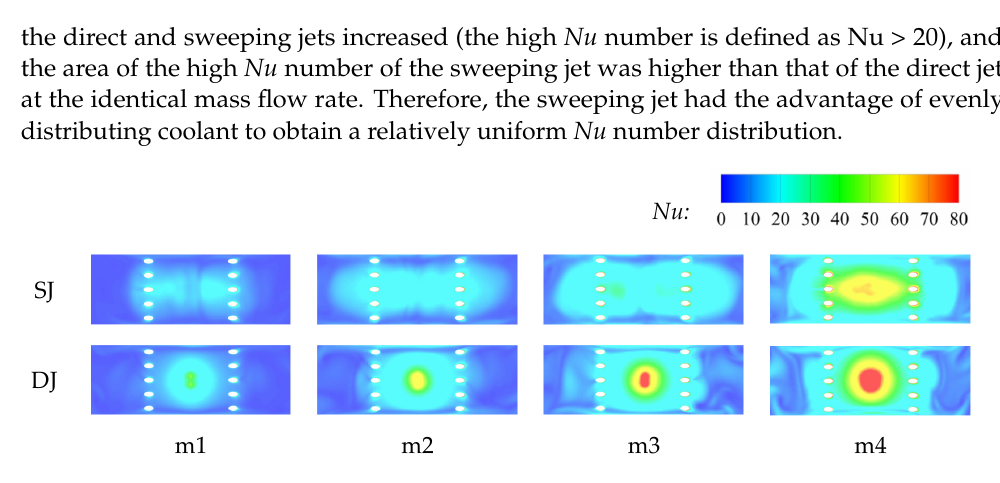
Figure 7. Time ‐ averaged Nu number contours on the impinging surface at α = 30°. Figure 7. Time-averaged Nu number contours on the impinging surface at α = 30 ◦ . Table 4. The Area ‐ averaged Nu number on impinging surface.